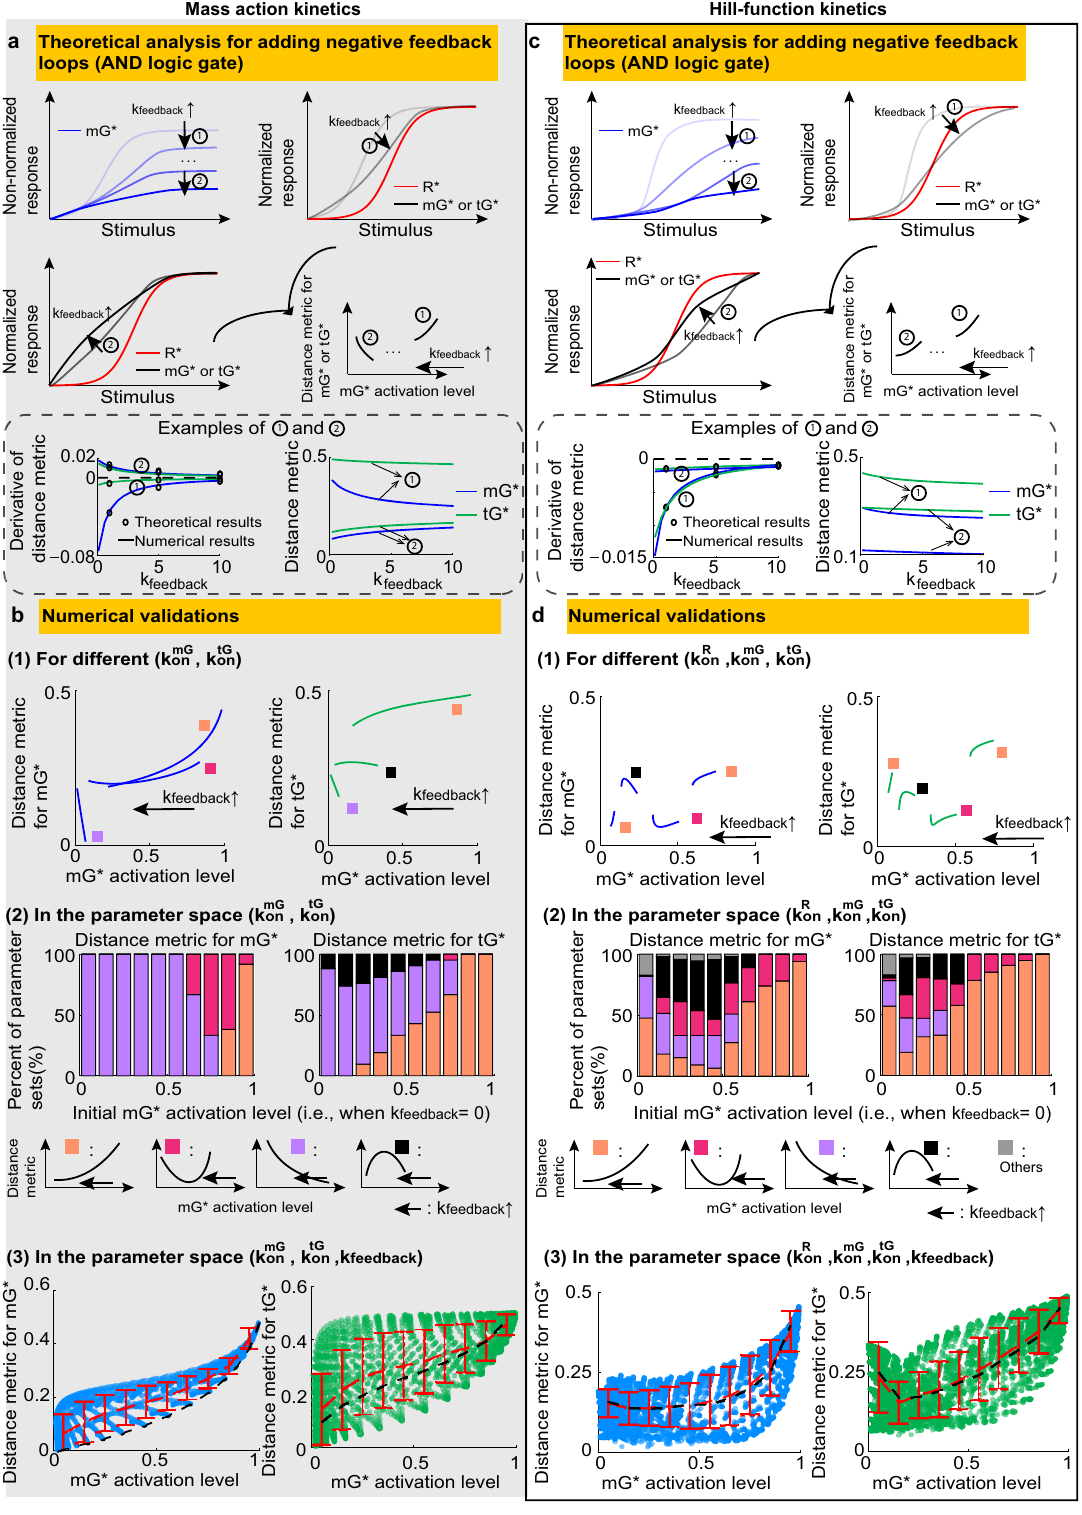
Fig. 3 Effects of adding the negative feedback. Same plot as in Fig. 2, except that the feedback strength k feedback is tuned while maintaining other kinetic parameters unchanged. The three dots in ( a ) indicate the region where the nonmonotonic change of the distance metric may occur. The bottom panels in ( a ) and ( c ) show how the derivative of the distance metric and the distance metric itself are determined by k feedback under different parameters; the derivative obtained from the formula is the same as that from the fi nite difference. In panels b (3) and d (3), the number of kinetic parameter sets is one-fourth of that in Fig. 2b(3) and Fig. 2d(3), and black dashed lines are the red dashed lines in Fig. 2b(3) and Fig. 2d(3). Here, the AND logic gate is used to model the negative feedback loops. See Supplementary Table 1 for